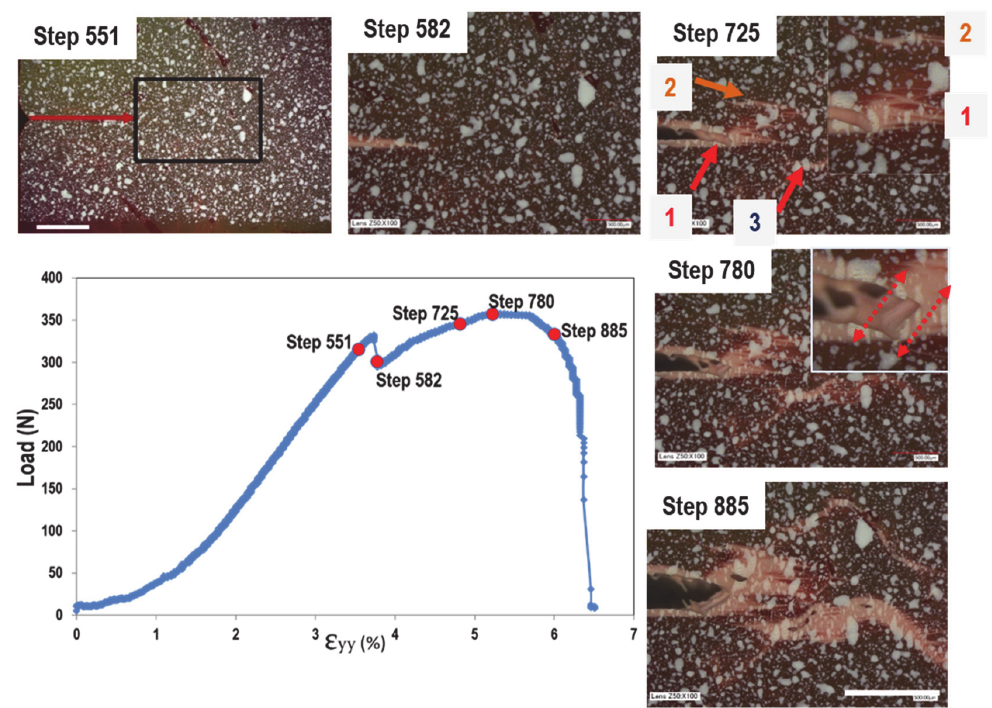
Figure 2: Strain evolutions from the optical images. The image at step 551 is recorded at the magnification x50, the notch is not visible at this loading level. The applied load leads to the sudden opening of the notch. The images recorded after the notch opening is at the magnification x100 to allow a better visualisation of the local strain evolutions. The scale bar is 1 mm in all the images.